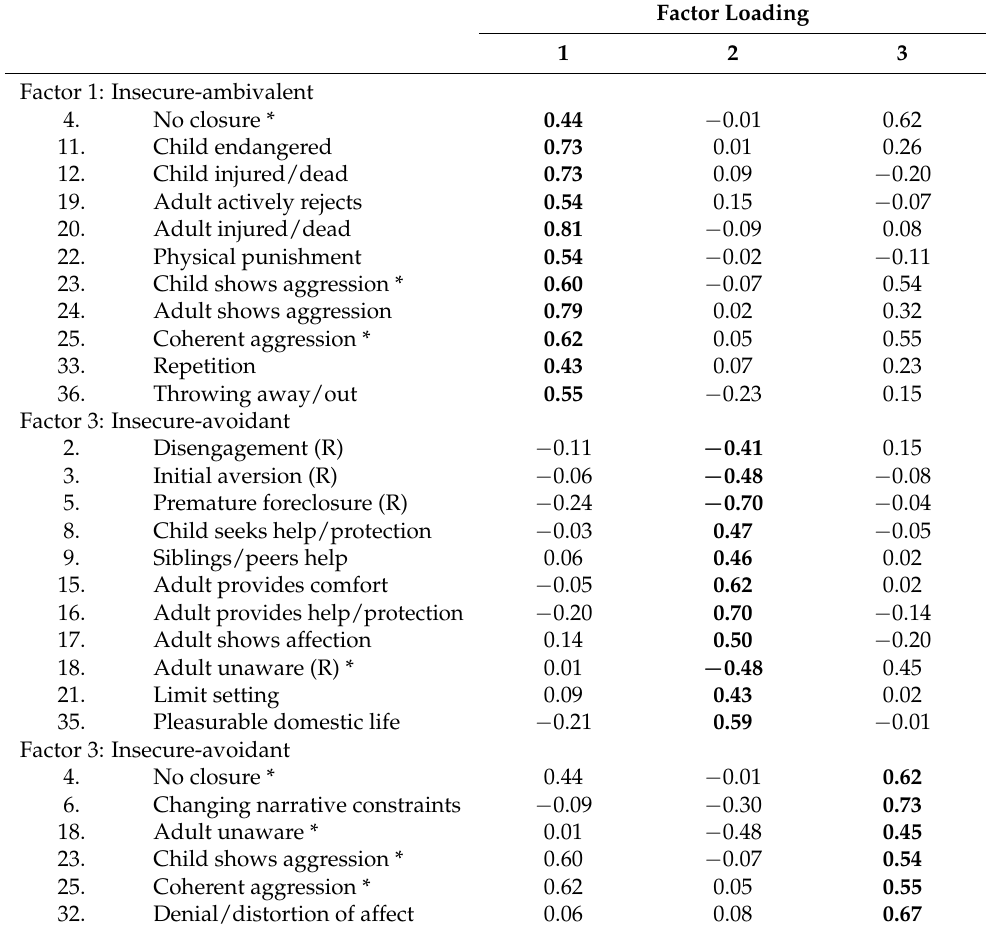
Table 2. Results From a Factor Analysis of Items of the Little Piggy Narrative (LPN) Coding